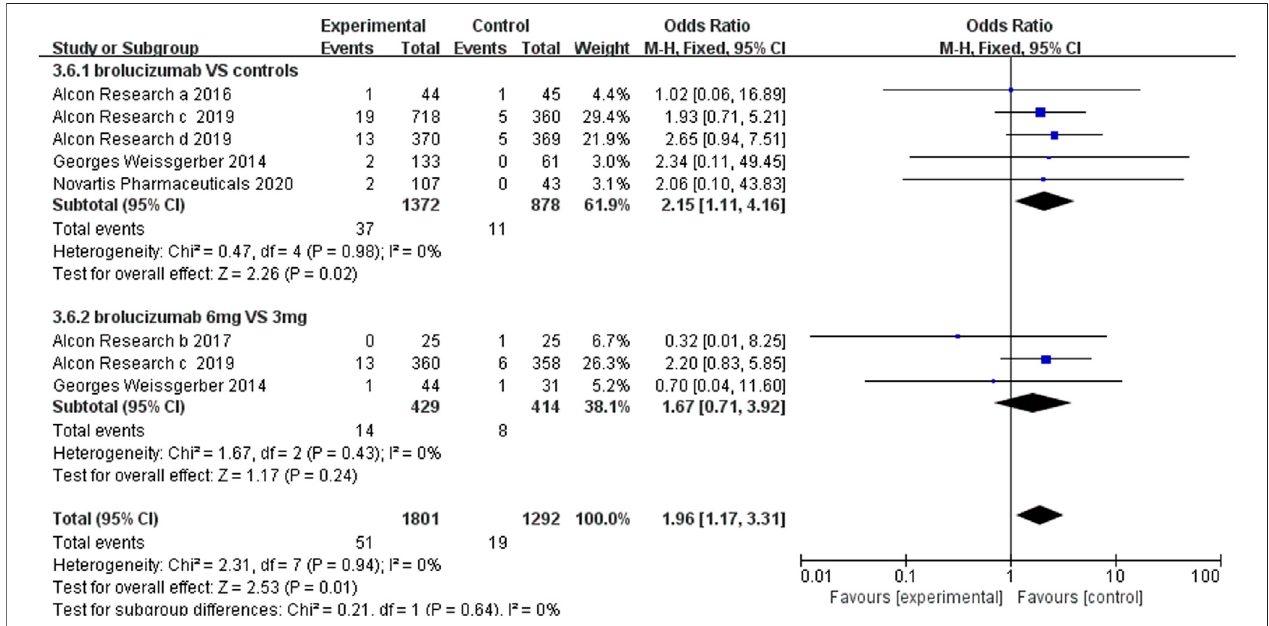
FIGURE 7 | Forest plots of the serious ocular adverse